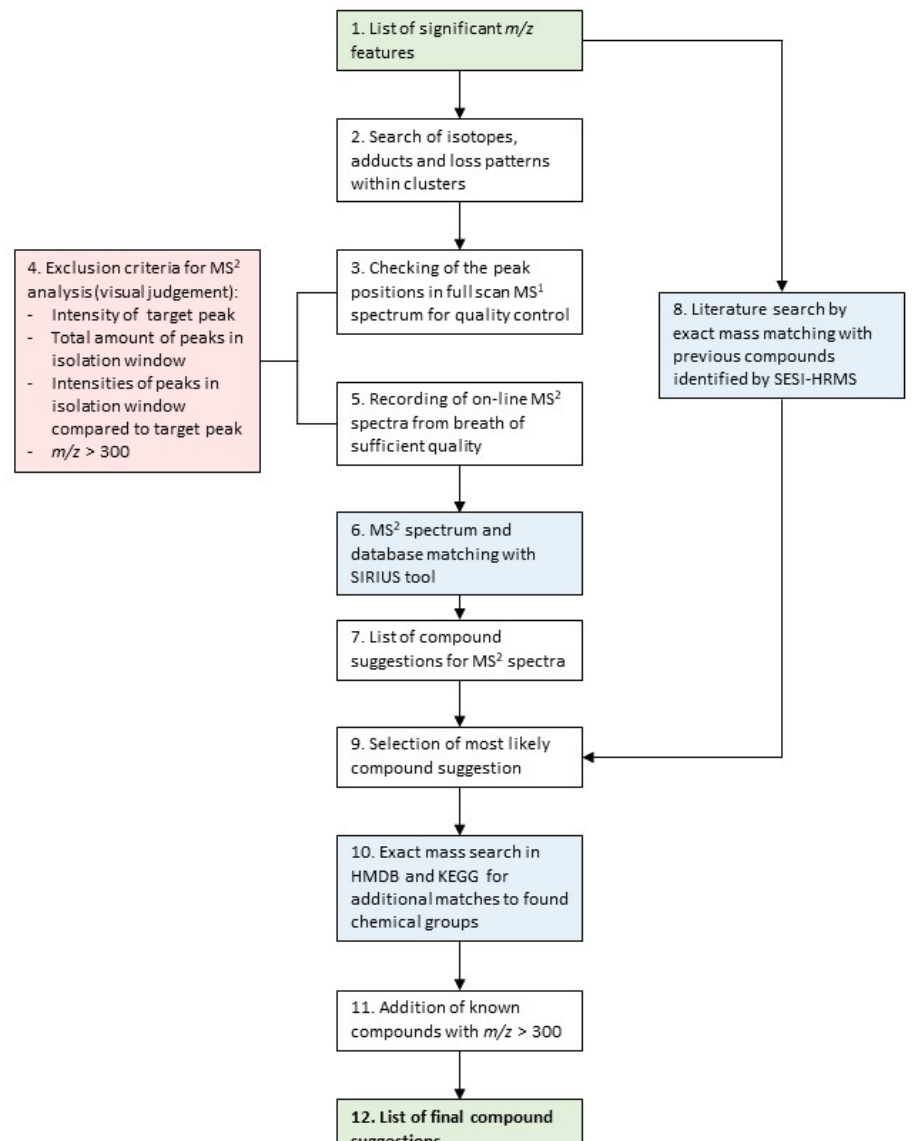
Figure 1. Schematic overview of the applied compound identification workflow. Details of the individual steps are described below.